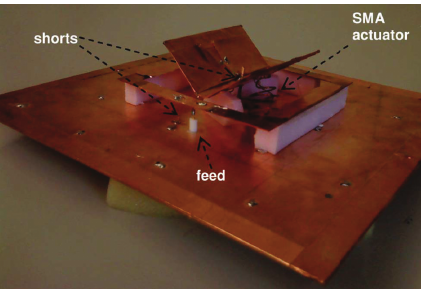
Figure 15: Reconfigurable square ring-patch antenna with dual-flap ground-shorted parasitic patch [31].